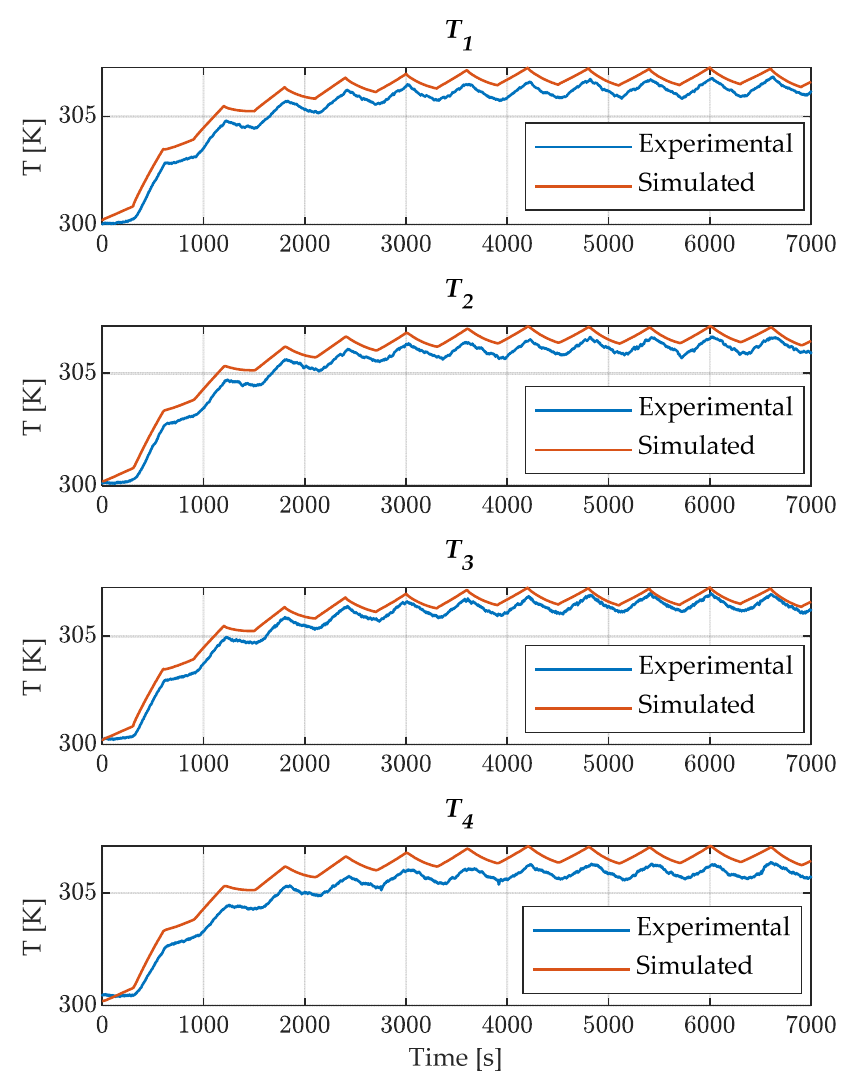
Figure 13. Thermocouples results for the single cell test at 15 A.